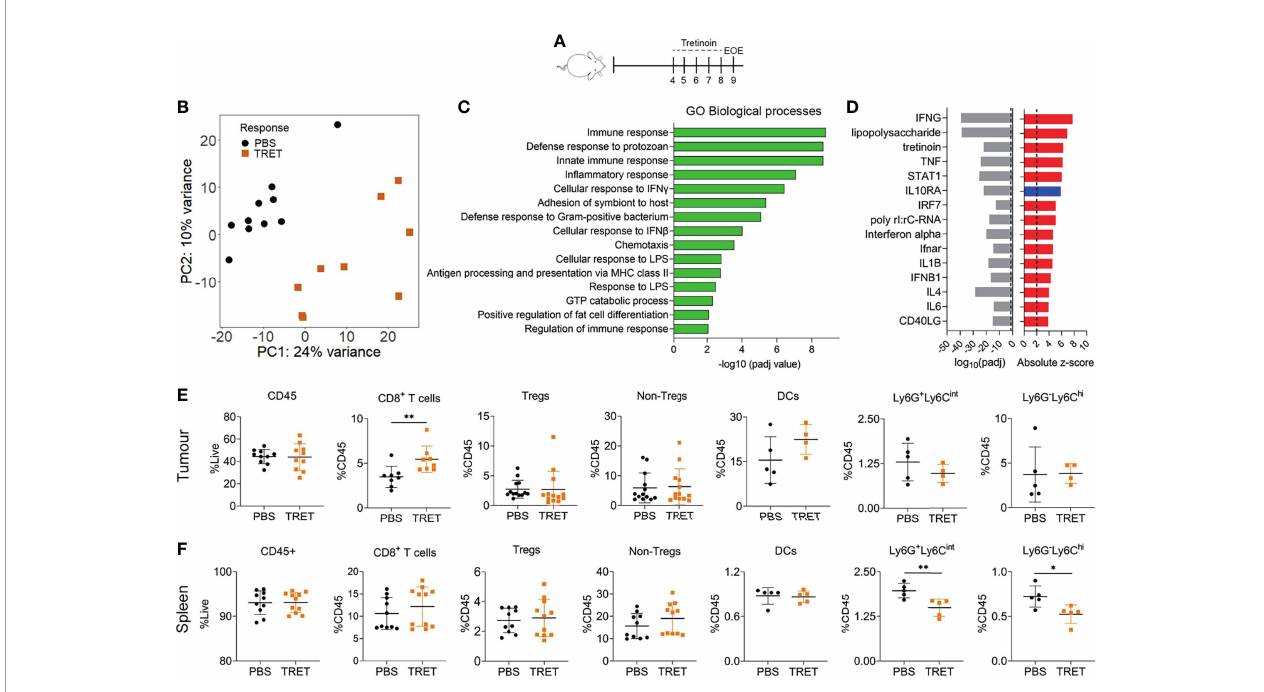
FIGURE 1 | Tretinoin induces an in fl ammatory, IFN driven tumour microenvironment. (A) Experimental design. Mice were inoculated with AB1-HA s.c and treated with 10 mg/kg tretinoin daily for 5 days starting at day 4 when tumours were ~4 mm 2 . Tumours and spleens from tretinoin treated and control (PBS treated) mice were collected for analysis. (B) Principal component analysis of tumour derived gene expression data from tretinoin treated (orange square, n=9) or control (black circle, n=10) mice. (C) Gene ontology analysis displaying biological pathways upregulated by tretinoin treatment, corrected for multiple comparisons. (D) Ingenuity upstream regulator analysis showing absolute z score of positive (red) or negative (blue) upstream regulators of a tretinoin associated gene signature and associated p values. (E, F) Proportion of immune cell populations (n=8-13 for lymphoid subsets and n=5 for myeloid subsets) in the tumour (E) or spleen (F) as determined by fl ow cytometry. For CIBERSORT and fl ow cytometry experiments, signi fi cance determined using a Mann-Whitney U test corrected for multiple comparisons. *p<0.05